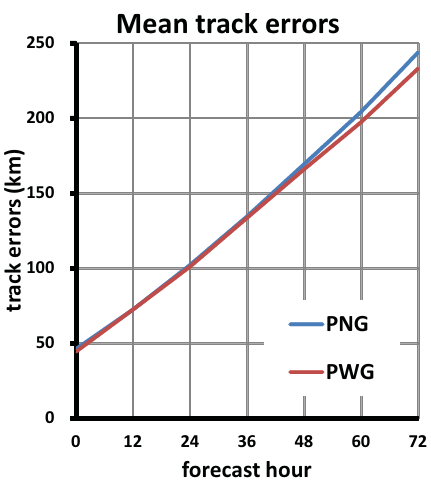
Figure 4. Mean track errors for PNG (blue line) and PWG (red line).